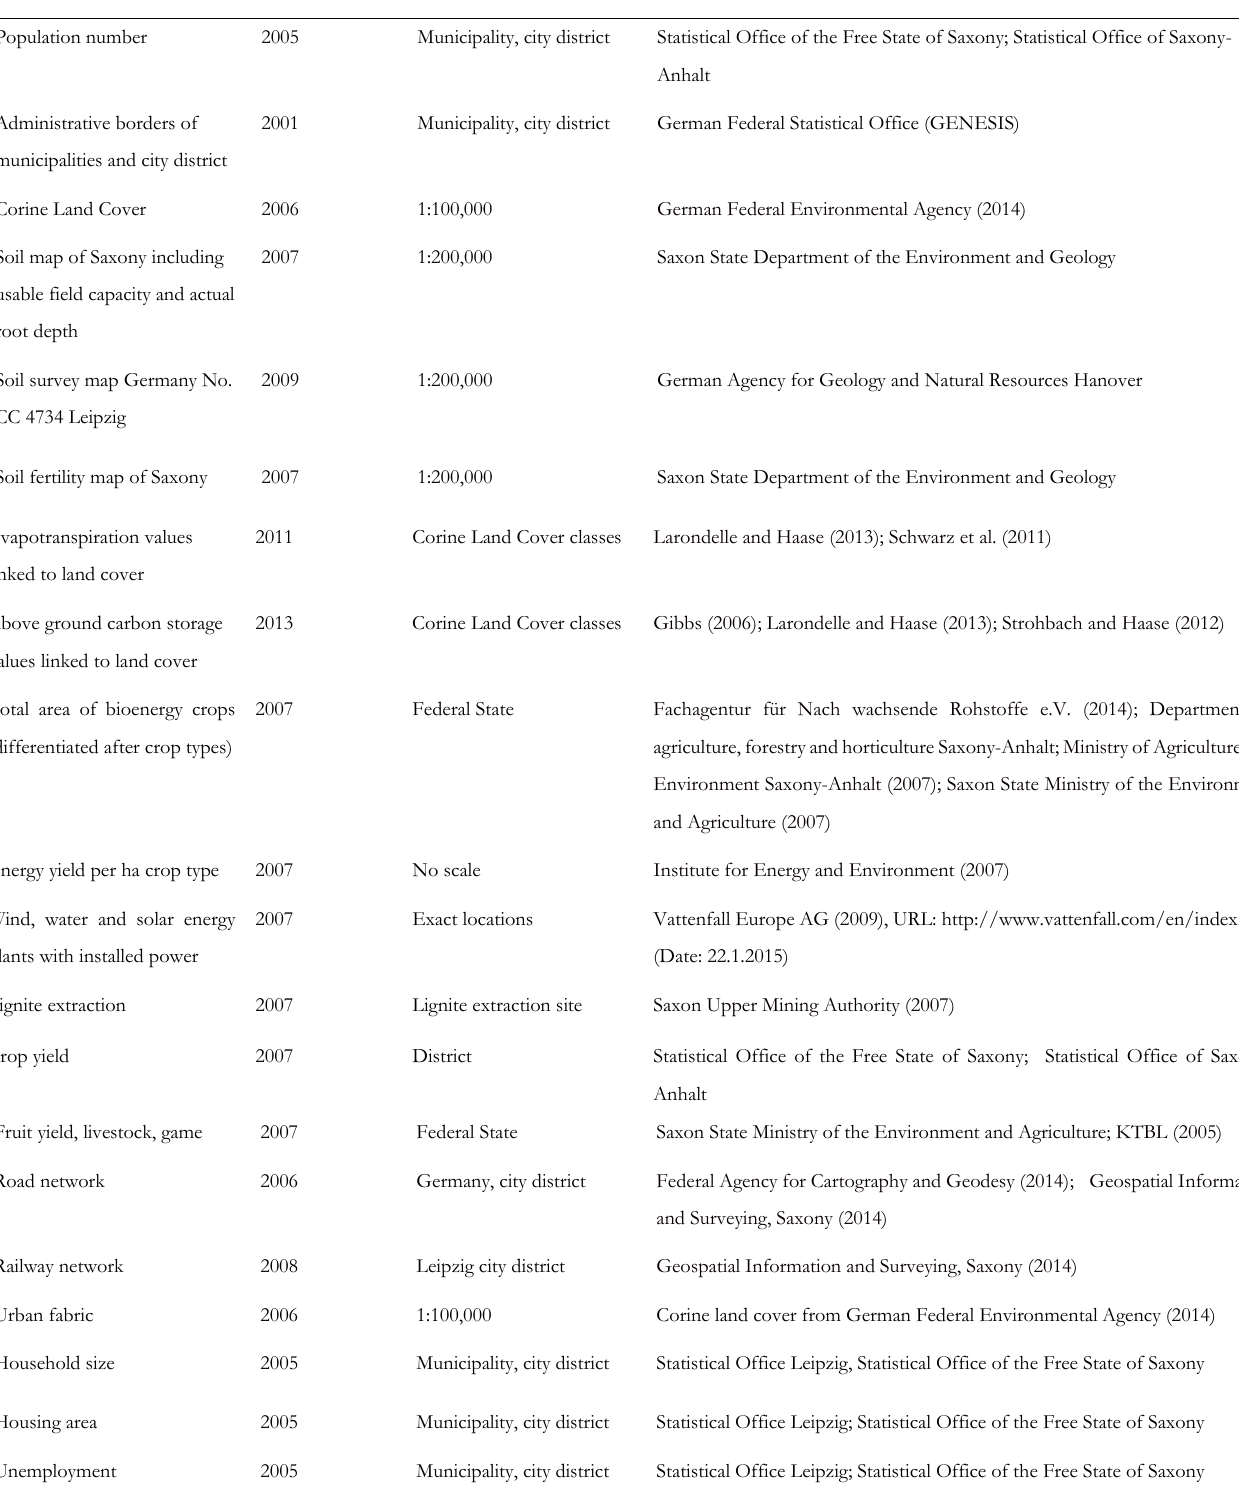
Table 4: Date uses, time, scales and sources for the study of Leipzig urban-rural area